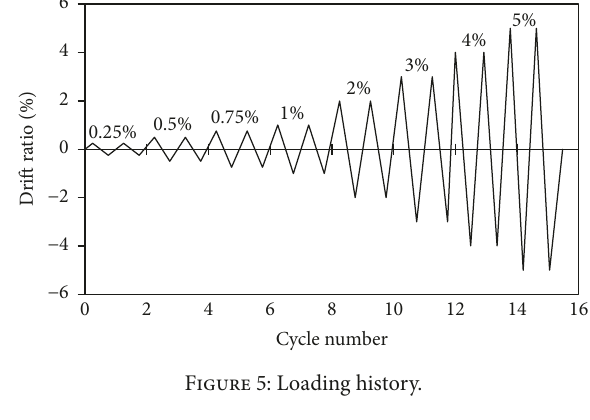
Figure 4: Test setup of specimens.